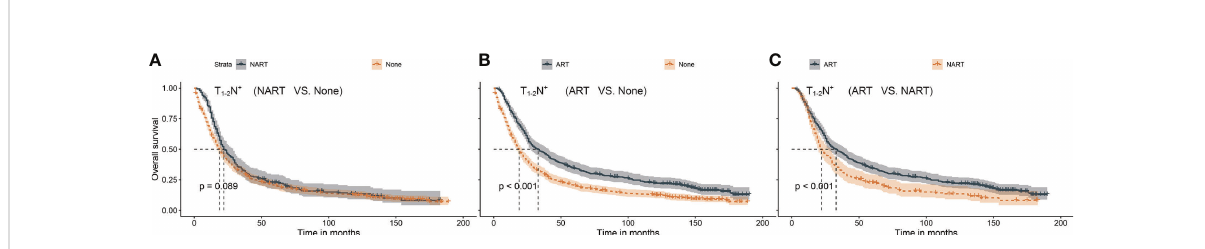
FIGURE 2 (A – C) Survival bene fi t after NART or ART in patients with T 1 – 2 N + . (A) NART failed to bene fi t patients with T 1 – 2 N + . (B) ART prolonged survival in patients with